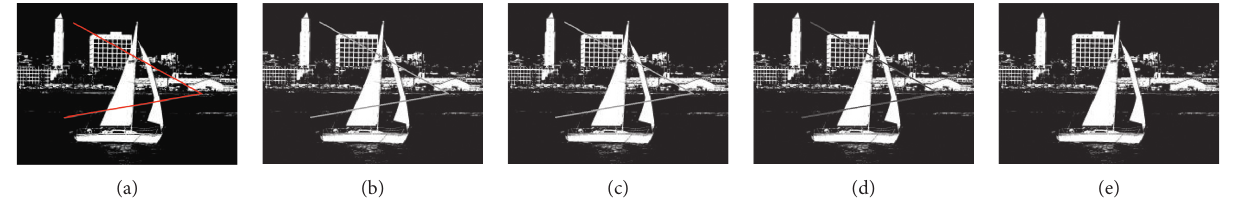
Figure 11: Comparison of the effect of scratch removal binary image repair. (a) Original image, (b) Criminisi algorithm result, (c)